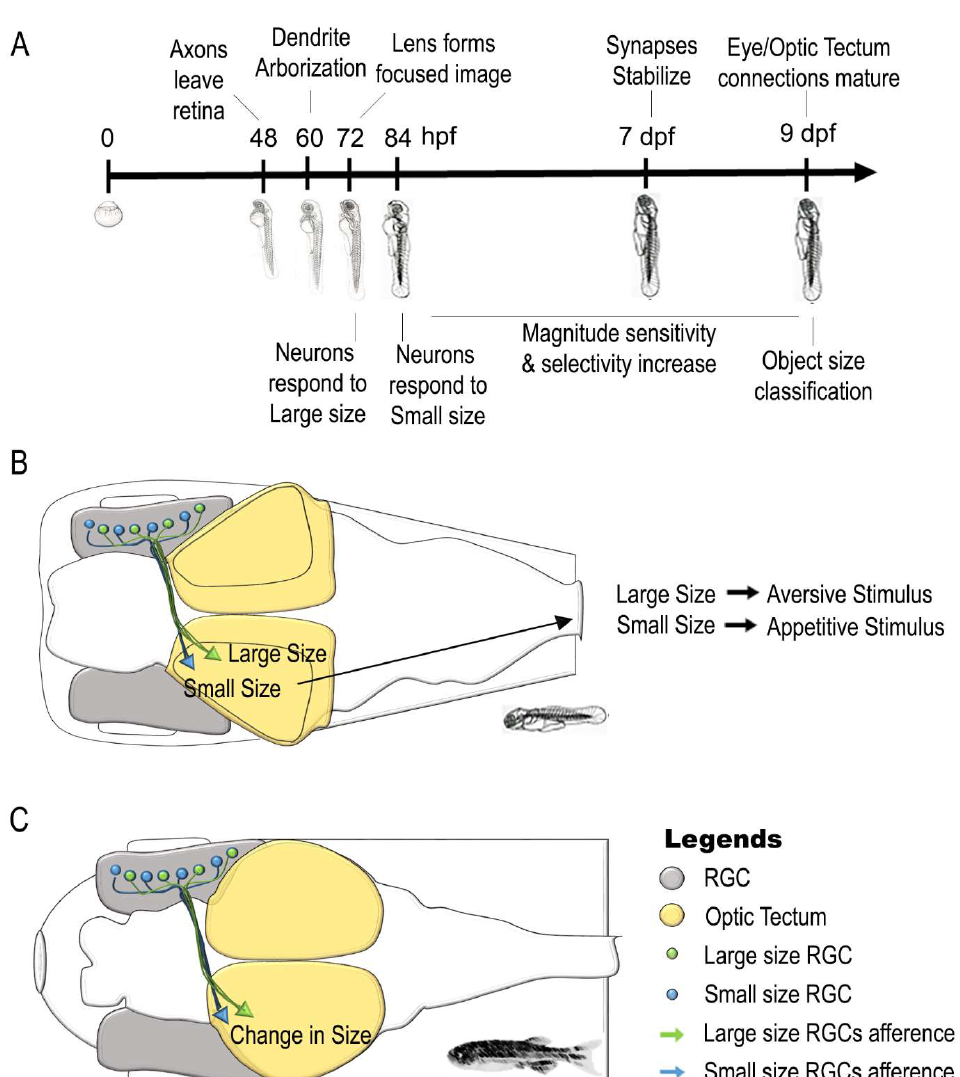
Figure 1. Neural correlates of continuous magnitude estimation in zebrafish. ( A ) Time line of development of continuous magnitude sense in zebrafish embryo and larva. ( B ) Scheme of retinotectal pathways involved in object size discrimination in zebrafish larvae using ethological relevant stimuli. ( C ) The retina and optic tectum are involved in object size classification of visual stimuli in habituation/dishabituation experiments in adult zebrafish brain. See main text and Table 1 for references.